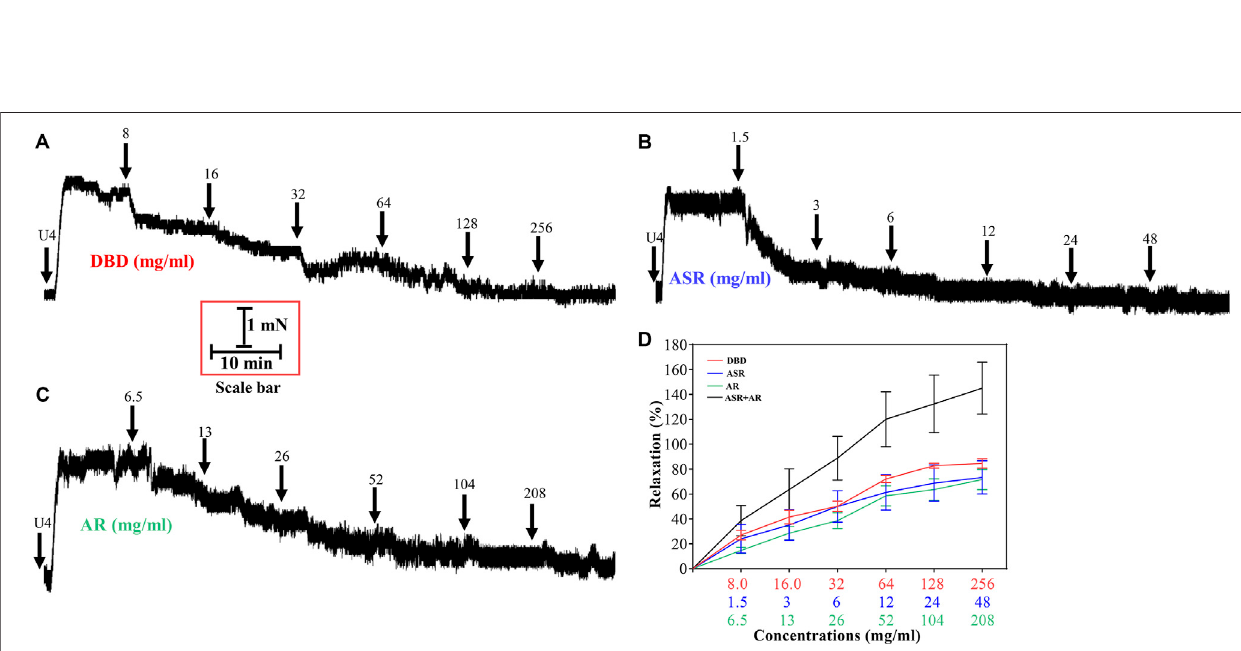
Frontiers in Pharmacology |